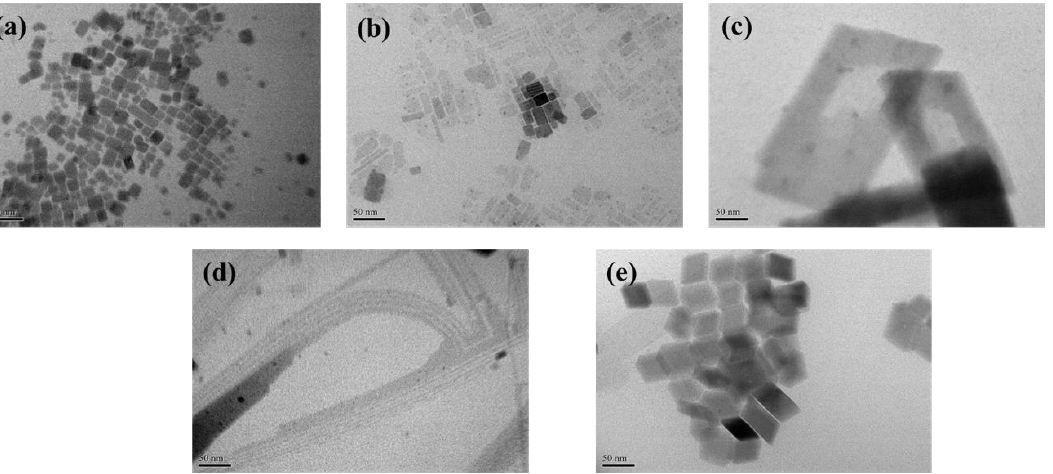
Figure 2. Transmission electron microscopy images of ( a ) as-synthesized NCs, ( b ) Olac 25, ( c ) Olac 50, ( d ) Olam 25, and ( e ) Olam 50.